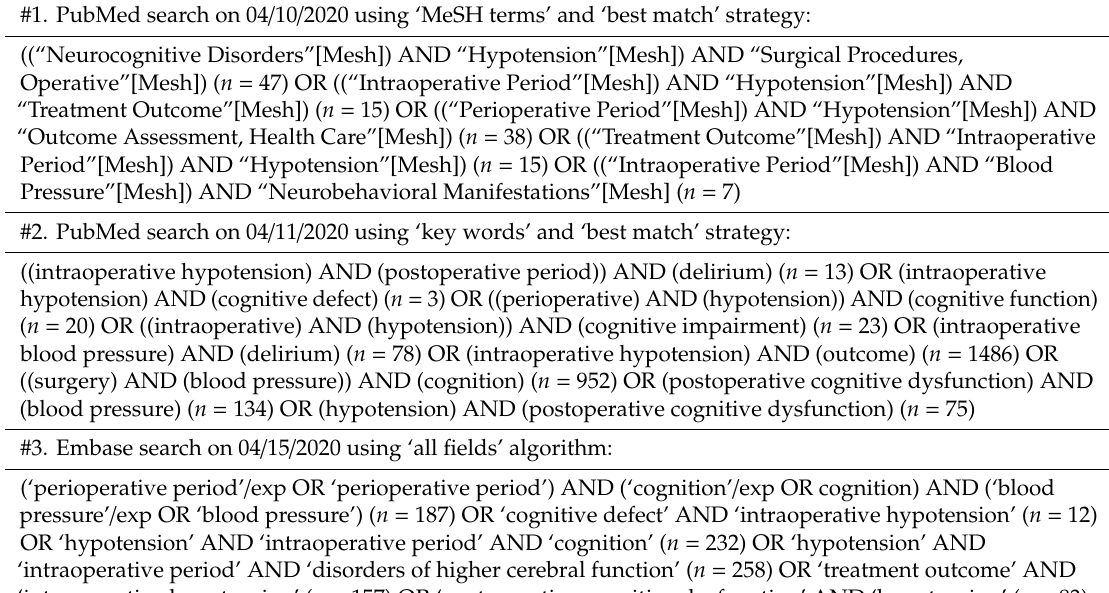
Table 4. Search strategy implemented in the